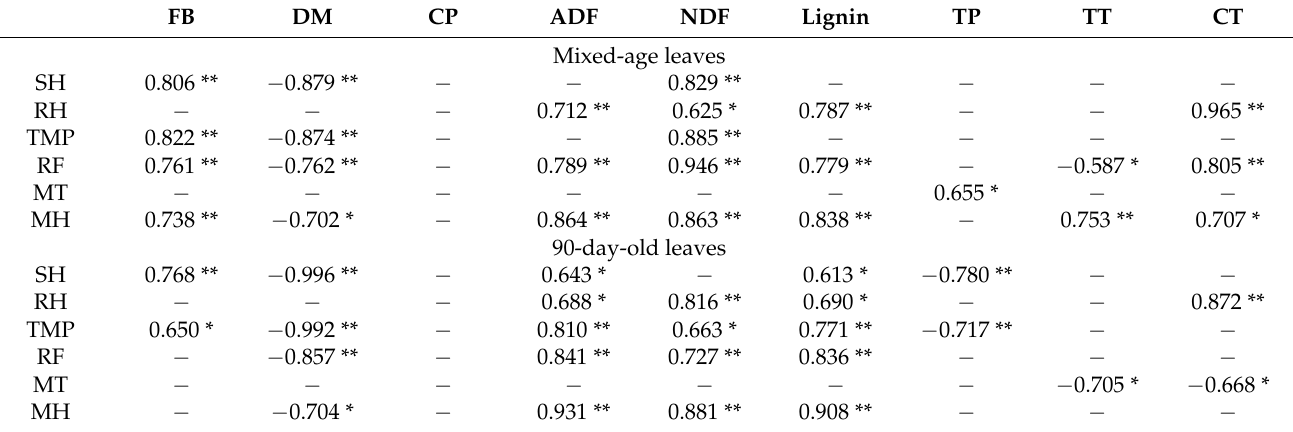
Table 2. Significant correlations of the macro- and microclimatic factors with leaf biomass (FB) and different bromatological components of Gymnopodium floribundum leaves at different harvest